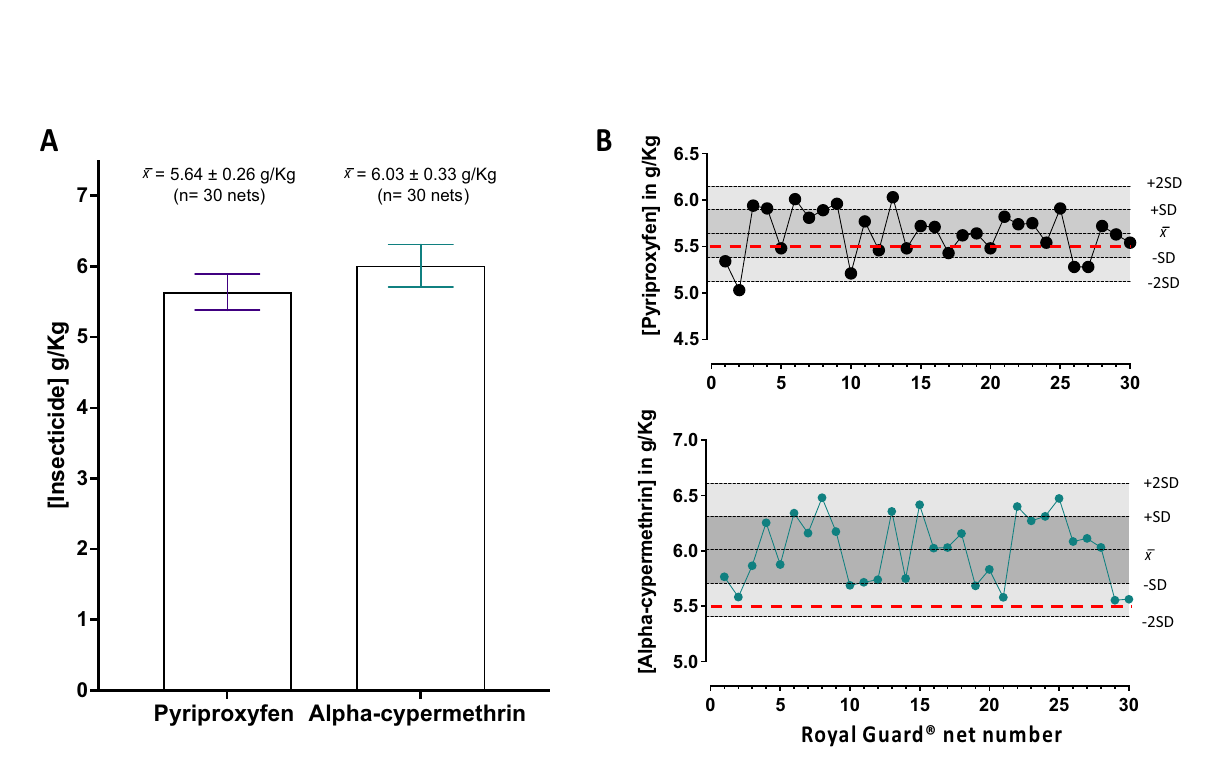
Figure 7. Analysis of total pyriproxyfen and alpha-cypermethrin content in Royal Guard® LLIN. ( A ) The average content of pyriproxyfen and alpha-cypermethrin ± standard deviation (SD) for 30 Royal Guard® nets. ( B ) Levy-Jenning’s charts for the 30 nets were analyzed by the optimized method. Pyriproxyfen (top chart) and alpha-cypermethrin (bottom chart) scored an average (x ̄ ) of 5.64 ± 0.26 and 6.03 ± 0.33 g/kg, respectively. Reference concentrations for both active ingredients declared by the manufacture are denoted as red dotted lines on the